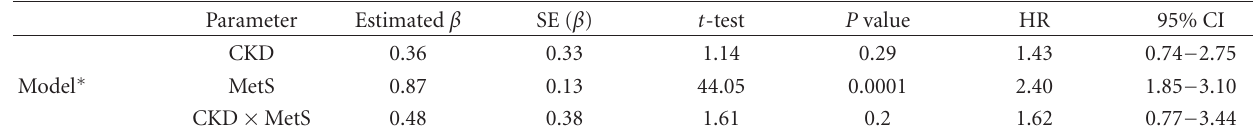
Table 4: Output from proportional hazards models.